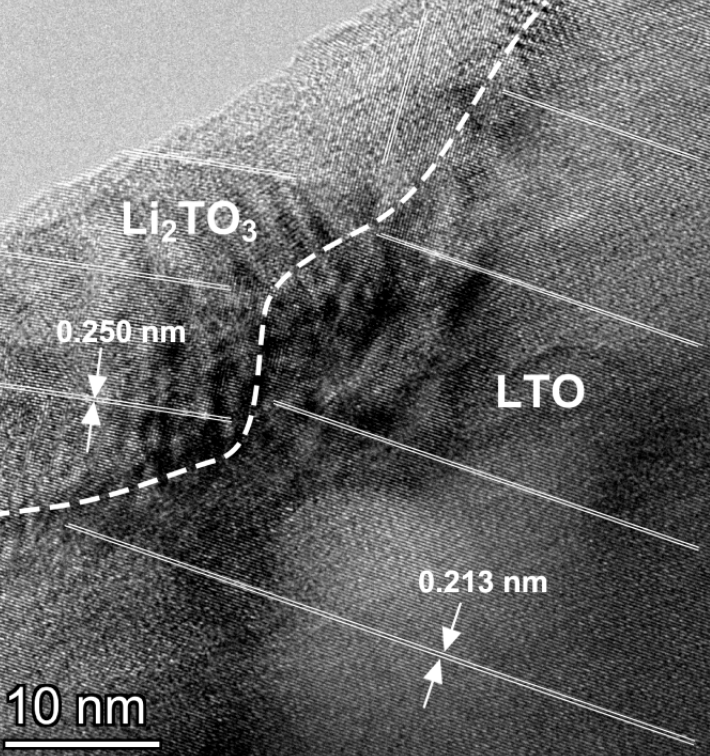
Figure 7. An HRTEM image obtained from the near-surface area of the LTC composite particle. Lines correspond to the crystallographic planes (200) of LTO and (400) or ( − 313) planes of Li 2 TiO 3 . The interface position is roughly indicated by a dotted line.